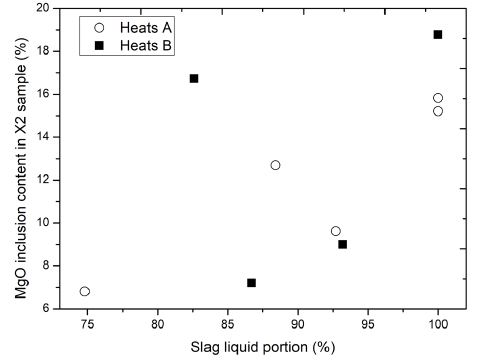
Figure 7. Relationship between the MgO content in the inclusions and fraction mass percentage of the liquid phase in